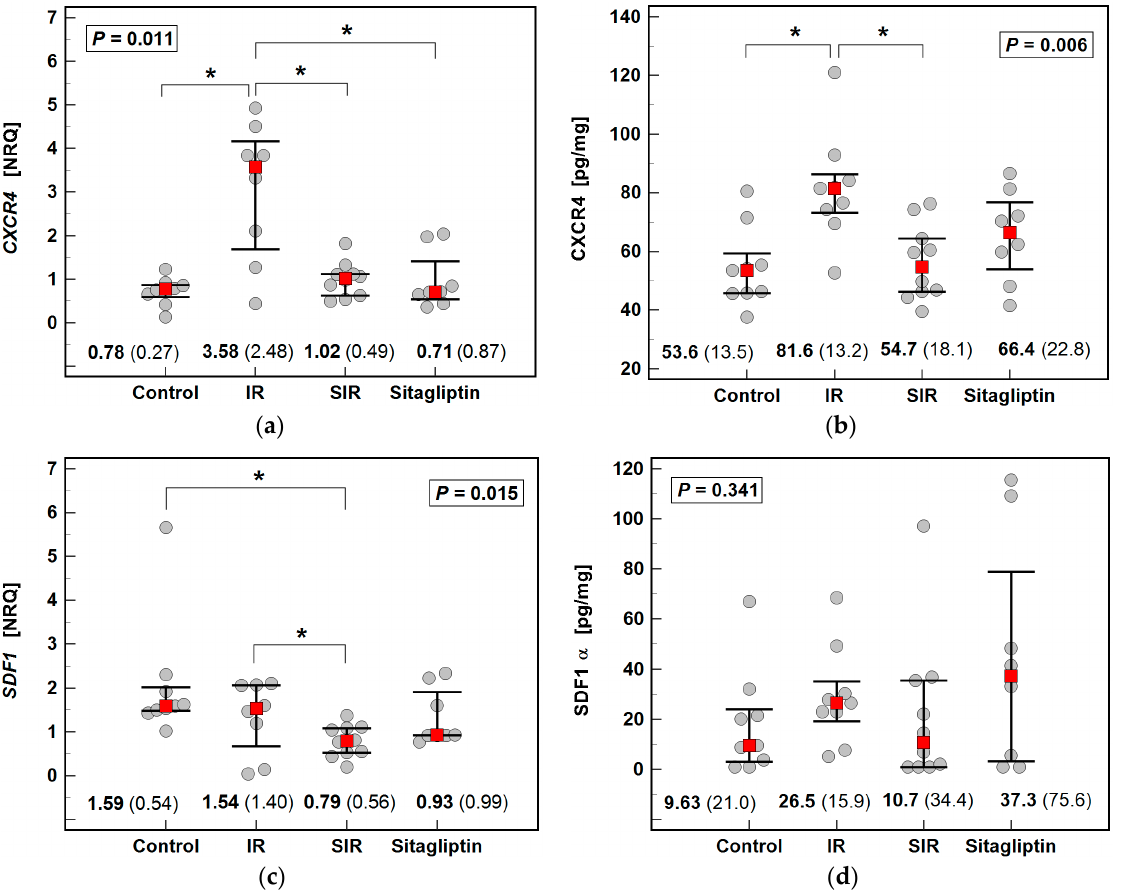
Figure 2. Effect of IR injury and sitagliptin on CXCR4/SDF1 axis in the liver: ( a ) Cxcr4 expression; ( b ) CXCR4 concentration; ( c ) Sdf1 expression; ( d ) SDF1 α concentration. Data were analyzed using the Kruskal–Wallis H test and are presented as medians with IQR (red squares with whiskers and numbers below dot-plots). Significant ( p < 0.05) differences between groups, identified in post-hoc analysis (Conover test), are indicated by connectors with * symbol. NRQ, normalized relative quantity; IR, ischemia-reperfusion; SIR, sitagliptin pretreatment and ischemia-reperfusion; IQR, interquartile range.